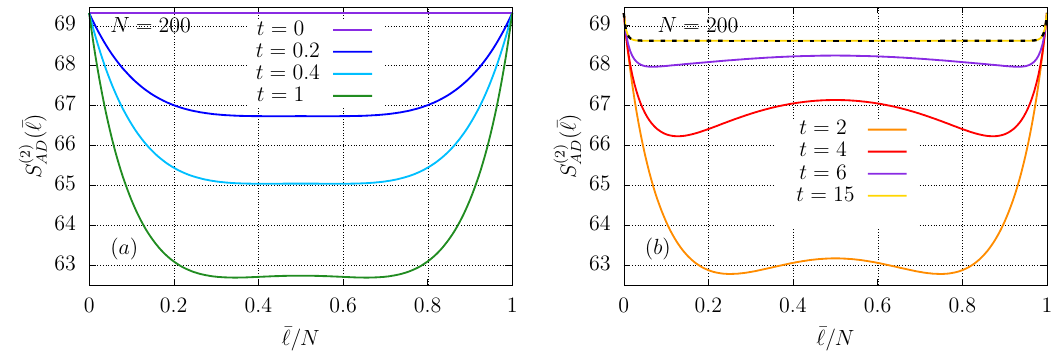
for the subsystem A D , as displayed AD [